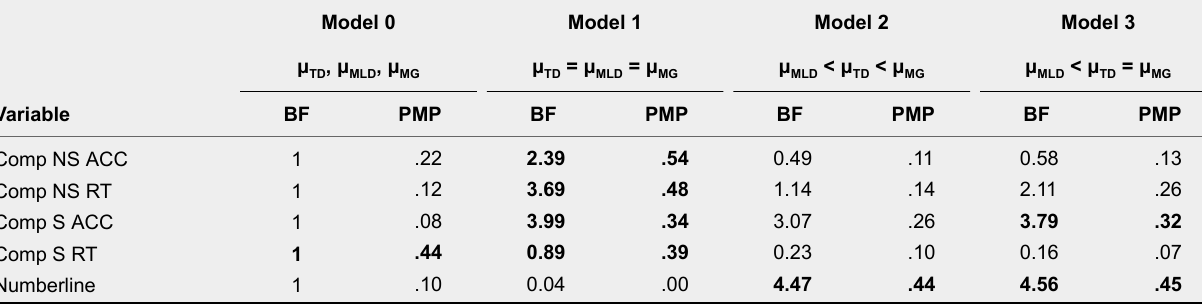
Comparison of Groups on Domain-Specific Variables, Corrected for IQ